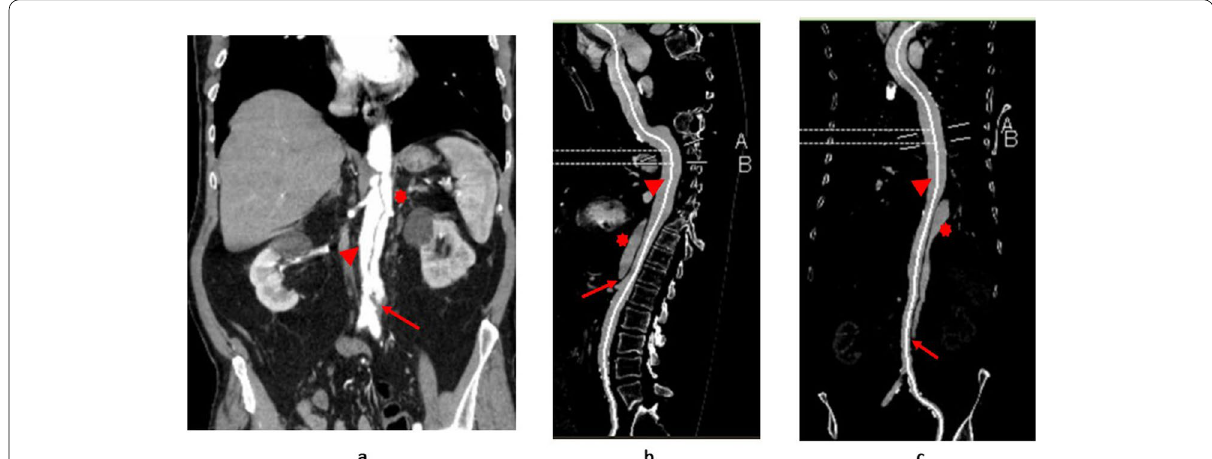
Fig. 1 Preoperative CT scan of the chest ( a ), abdomen ( b ) and pelvis ( c ) with IV contrast showing true lumen (red arrowhead) and false lumen (red asterix) as well as the dissection flap (red